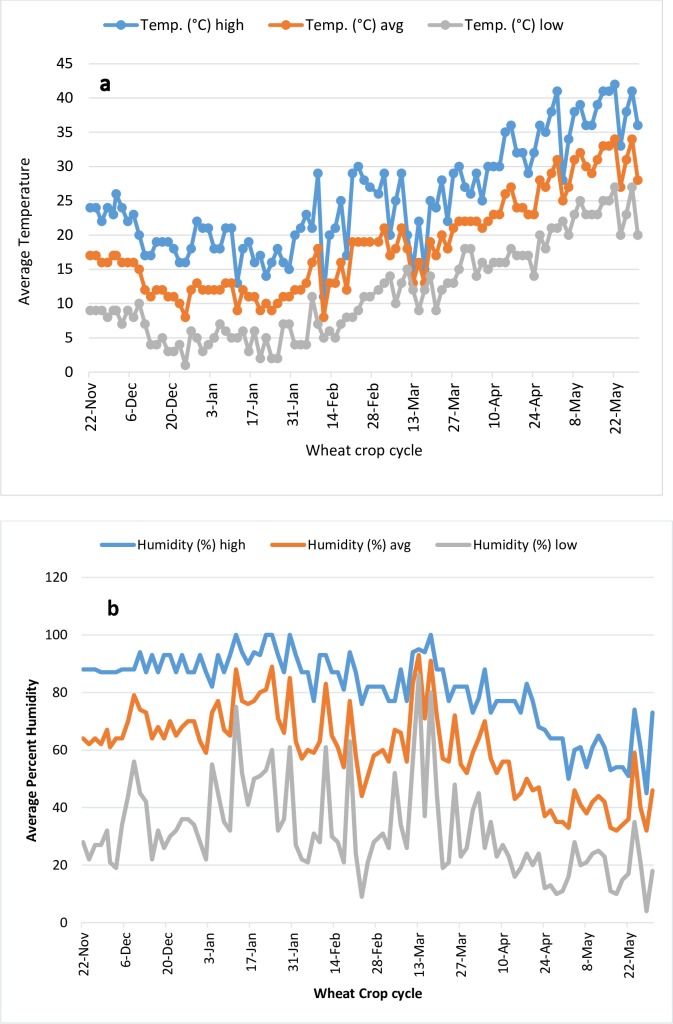
a: Averaged two-year maximum minimum and average temperature of experimental location. b. Averaged two-year maximum, minimum and average percent humidity of experimental location.